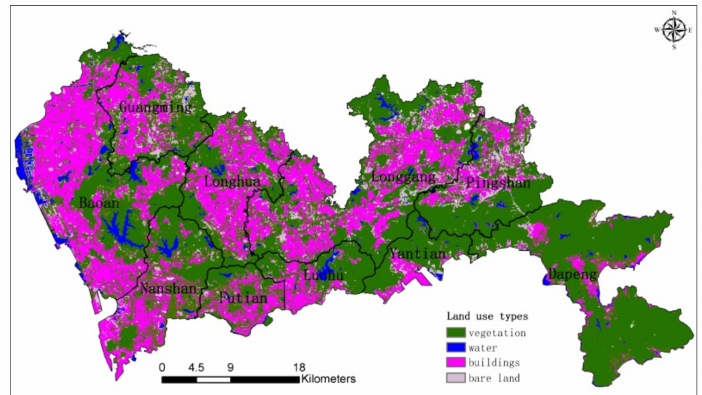
Figure 9. Land use types in Shenzhen.